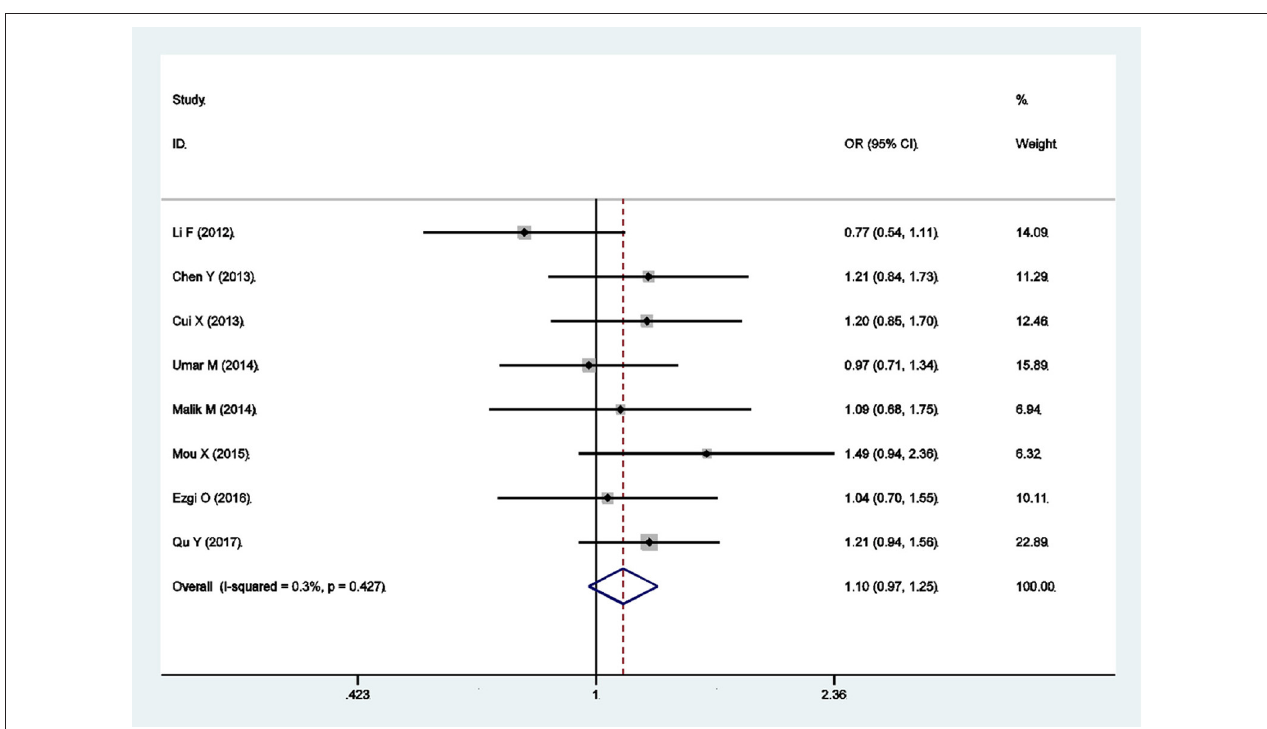
FIGURE 3 | Forest plots for rs3765524 polymorphism and cancer risk in dominant model (CT + TT vs.